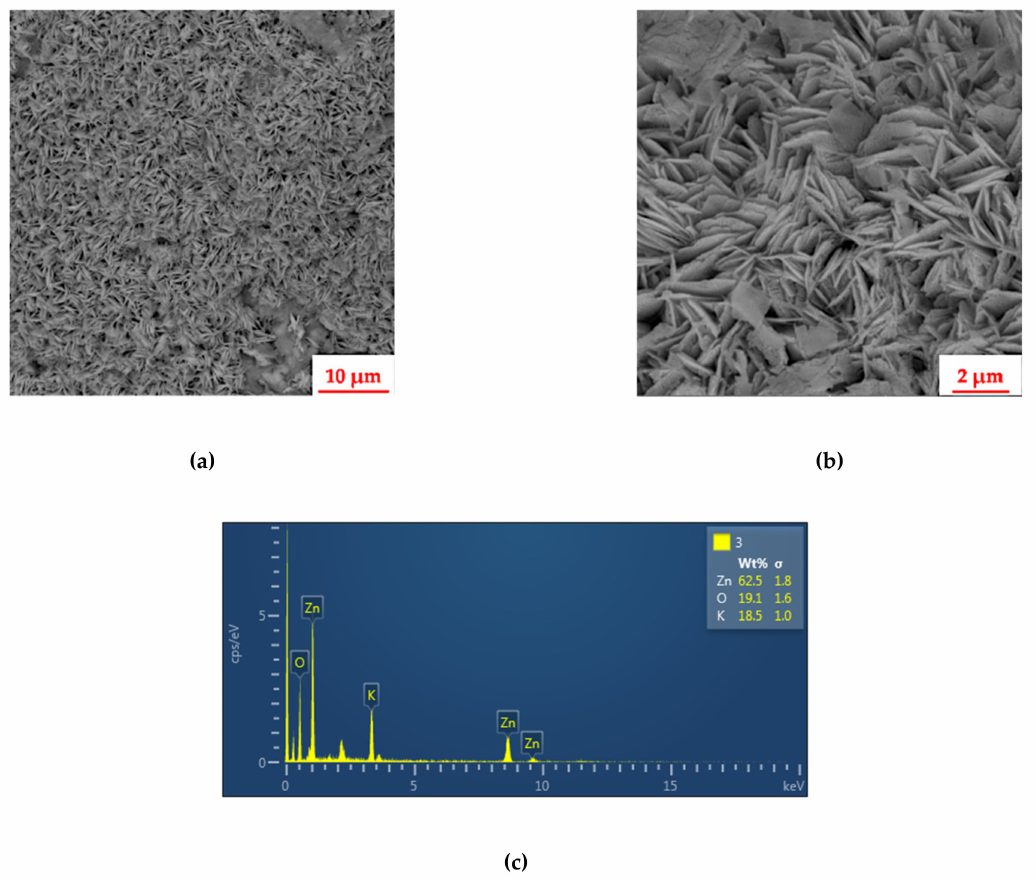
Figure 4. SEM images of ZnO Acetate sample: ( a ) 5000 × magnification (10 µ m marker); ( b ) 20,000 × magnification (2 µ m marker); ( c ) EDS elemental